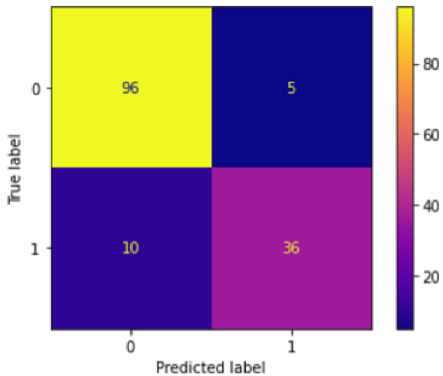
Figure 2. Confusion matrix of PCA+KNN at first-level